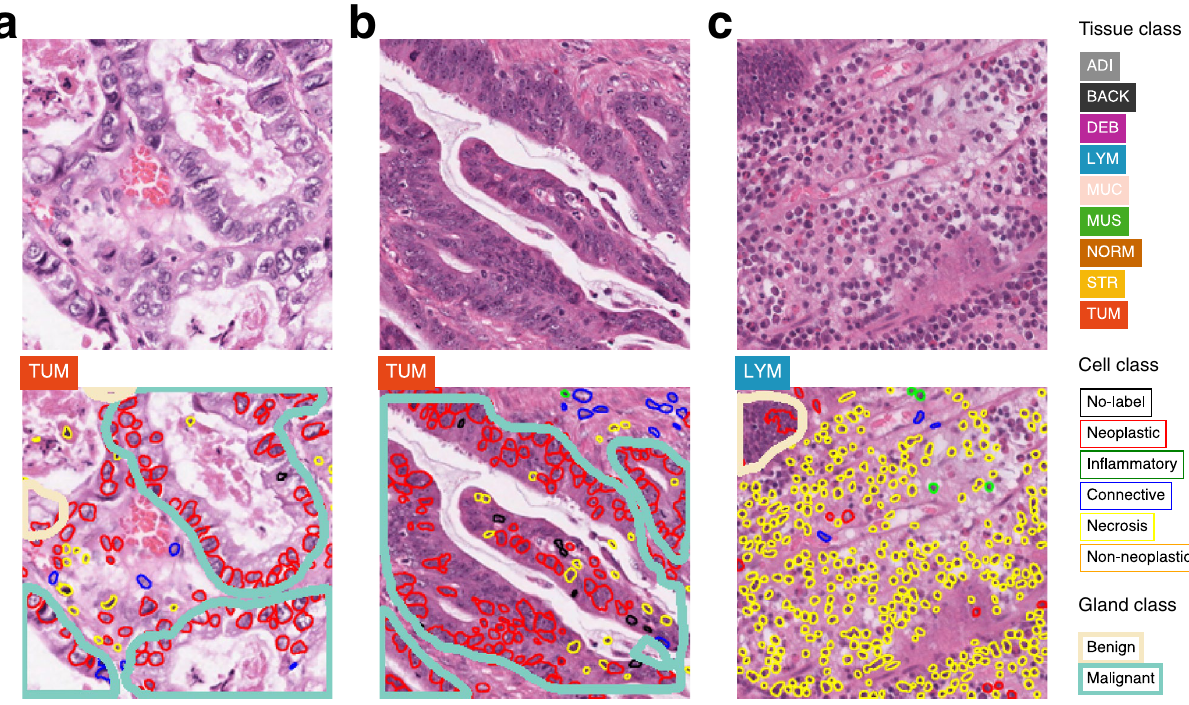
Figure 5. Representative patch samples. Patches sampled from TCGA-F5-6810 ( a ), TCGA-G4-6588 ( b ), and TCGA-AD-5900 ( c ). ( a ) Vesicular cells ( b ) A predominant tubular/papillary structure of the tumor glands is shown. ( c ) Patches classified as LYM tissue. Inflammatory cells (lymphocytes) are misclassified as necrotic cells. ADI adipose tissue, BACK background, DEB debris, LYM lymphocytes, MUC mucus, MUS smooth muscle, NORM normal colon mucosa, STR cancer-associated stroma, TUM colorectal adenocarcinoma epithelium. Scale bar 50 µ m. The figure was generated using Inkscape v1.1 (https:// inksc ape.